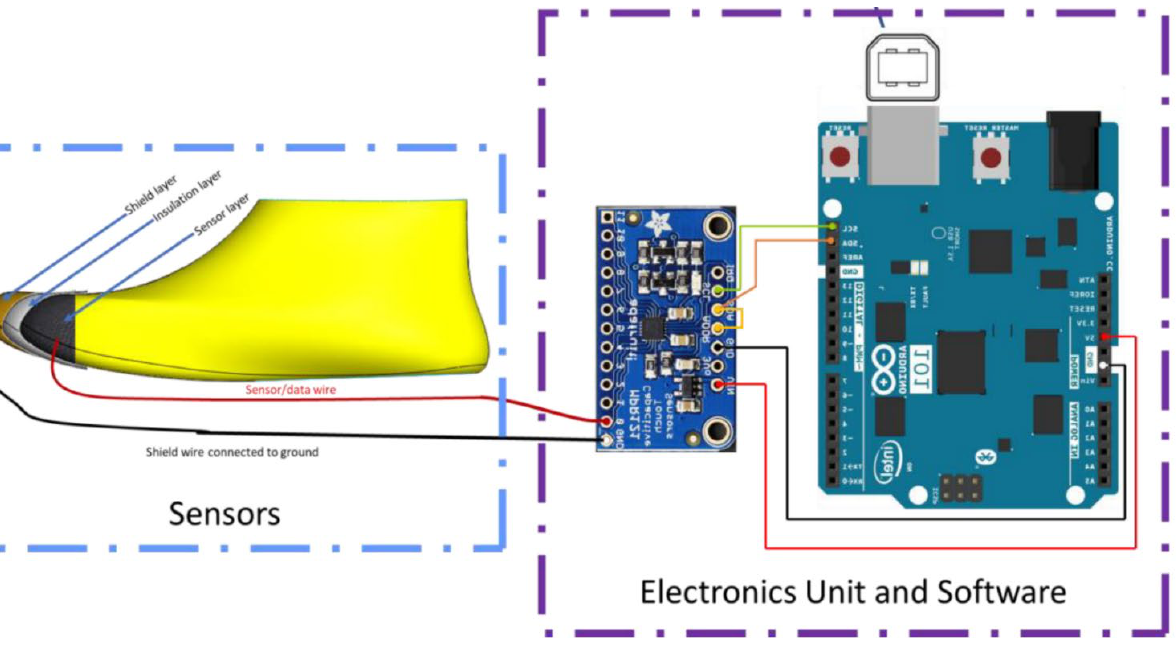
Figure 1. System layout for Sensor Prototype 1.